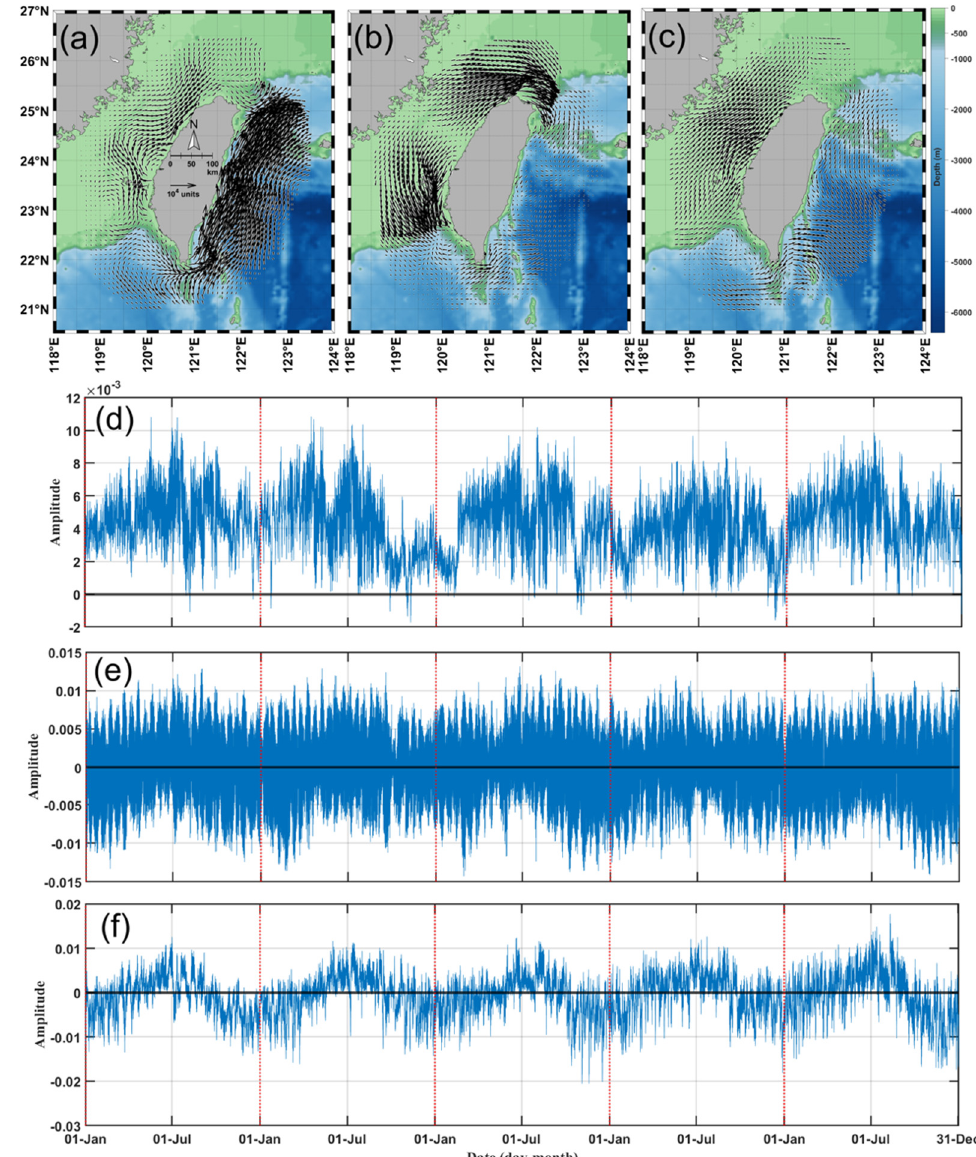
Figure 5. The spatial distribution of the EOF results, ( a ) the first EOF mode (EOF1), ( b ) the second EOF mode (EOF2) and ( c ) the third EOF mode (EOF3) of five-year data in the whole area around Taiwan and the corresponding time series of principal components, ( d ) EOF1, ( e ) EOF2 and ( f ) EOF3.